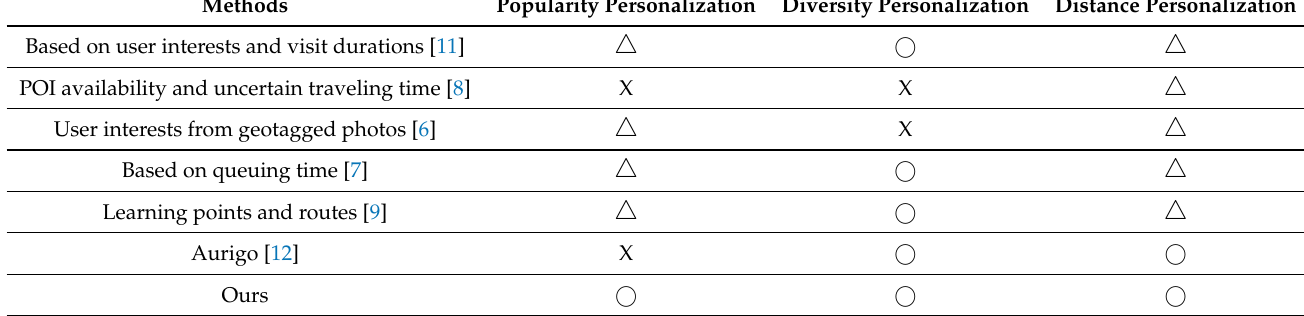
Table 1. Comparisons of related work and our method. X: does not reflect that aspect in recommen- dations; (cid:52) : reflects the aspect, but does not consider personalization of that aspect; O: personalizes and reflects that aspect into